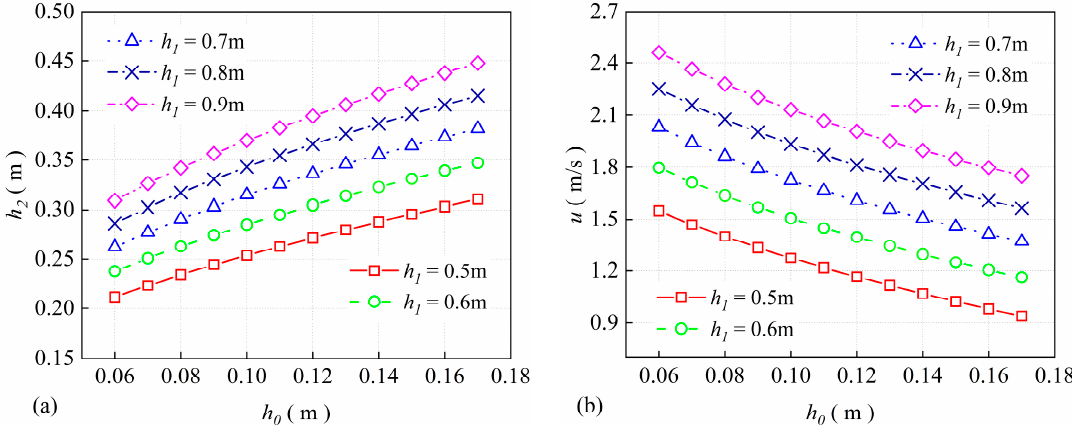
Figure 10. ( a ) Wave height and ( b ) wave speed calculated by Stoker’s theory.